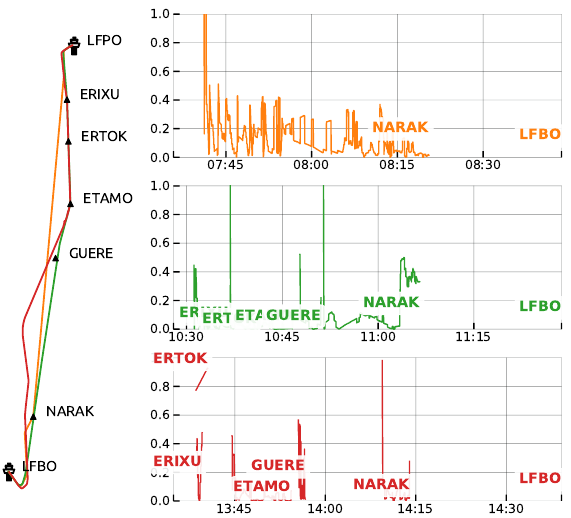
Figure 3. Different trajectories from Paris–Orly LFPO to Toulouse LFBO range from a direct to NARAK (entry point to the TMA) to a route following all the points of the flight plan. A long interval without a flight plan navigational point in heading may suggest an instruction from the ATC.